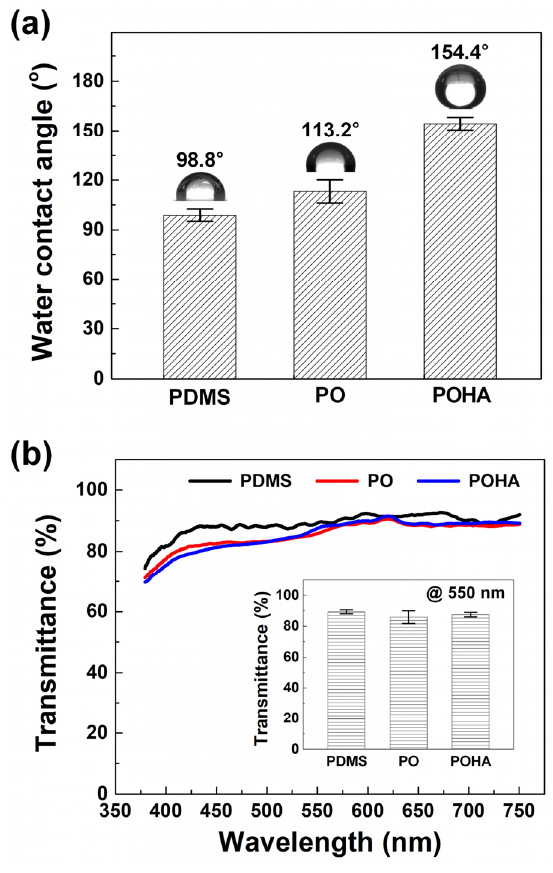
Figure 2. ( a ) Water-contact angles (WCAs) and ( b ) transmittance of PET substrates coated with PDMS, PO, and POHA films.